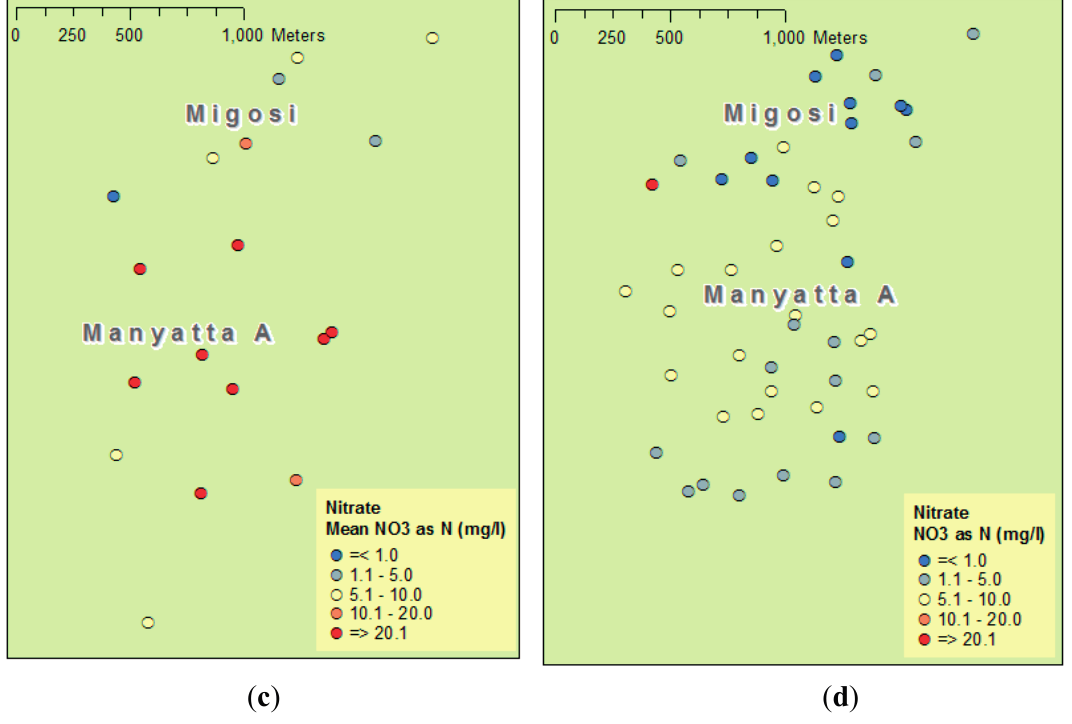
Figure 4. Maps of Manyatta A and Migosi showing pollutant concentrations in individual wells for: ( a ) Thermotolerant coliforms (TTC) 1998–2004 (geometric mean of all samples